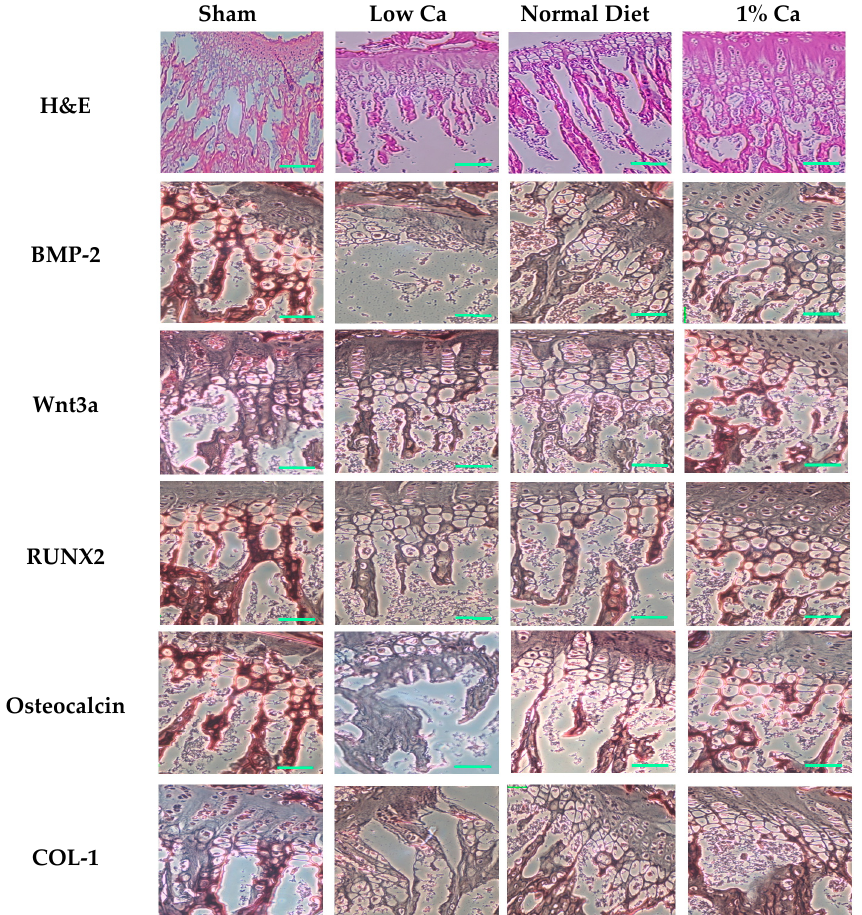
Figure 5. Hematoxylin and eosin (H&E) and immunohistochemical staining image of bone morphogenetic protein-2 (BMP-2), Wnt3a, runt-related transcription factor 2 (RUNX2), osteocalcin and collagenase-1 ( COL-1) in sham, low Ca, normal diet, and 1% Ca groups (scale bar: 40 μ m).